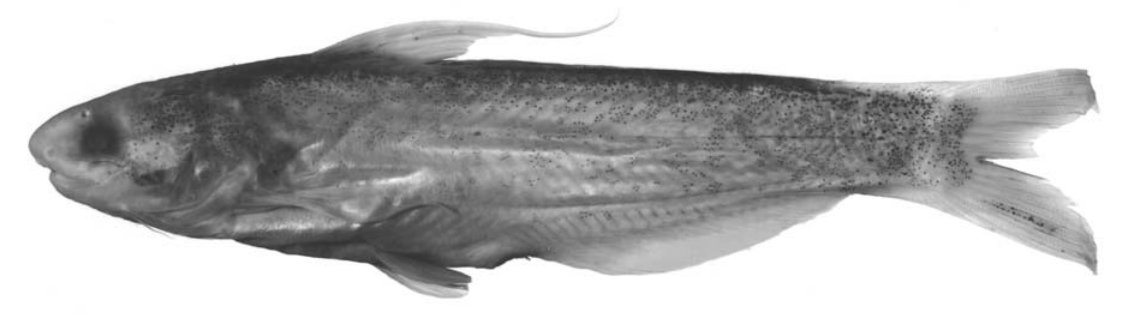
Fig. 36 . Cetopsis pearsoni , new species, holotype, mature male, MUSM 11093, 90 mm SL; Peru, Puno, Provincia de Sandia, río Candamo, Zona Reservada Tambopata-Candamo (13°28.97’S,